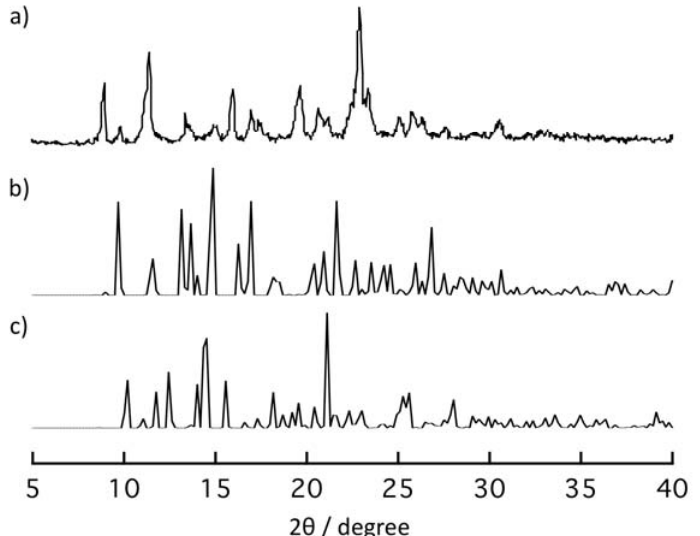
Figure S1. XRPD pattern after immersion of powder of 1  in m -xylene for a few days ( a ) at